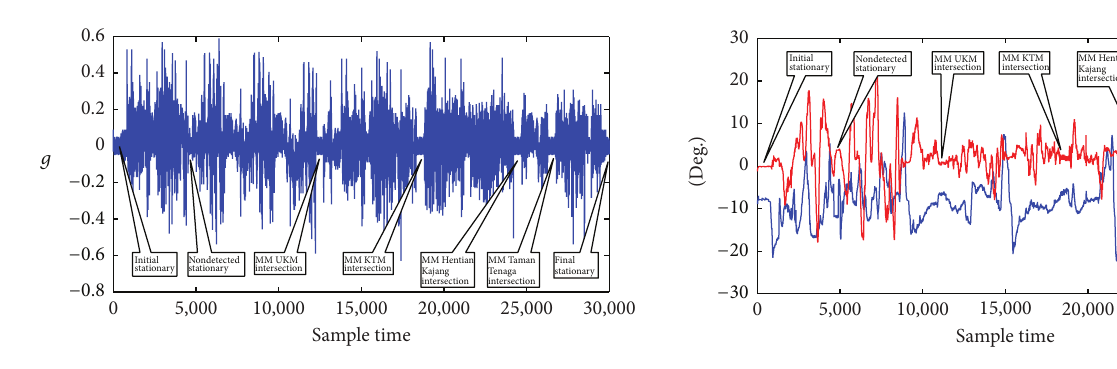
Figure 11: Stationary detection from acceleration signal in the first test.